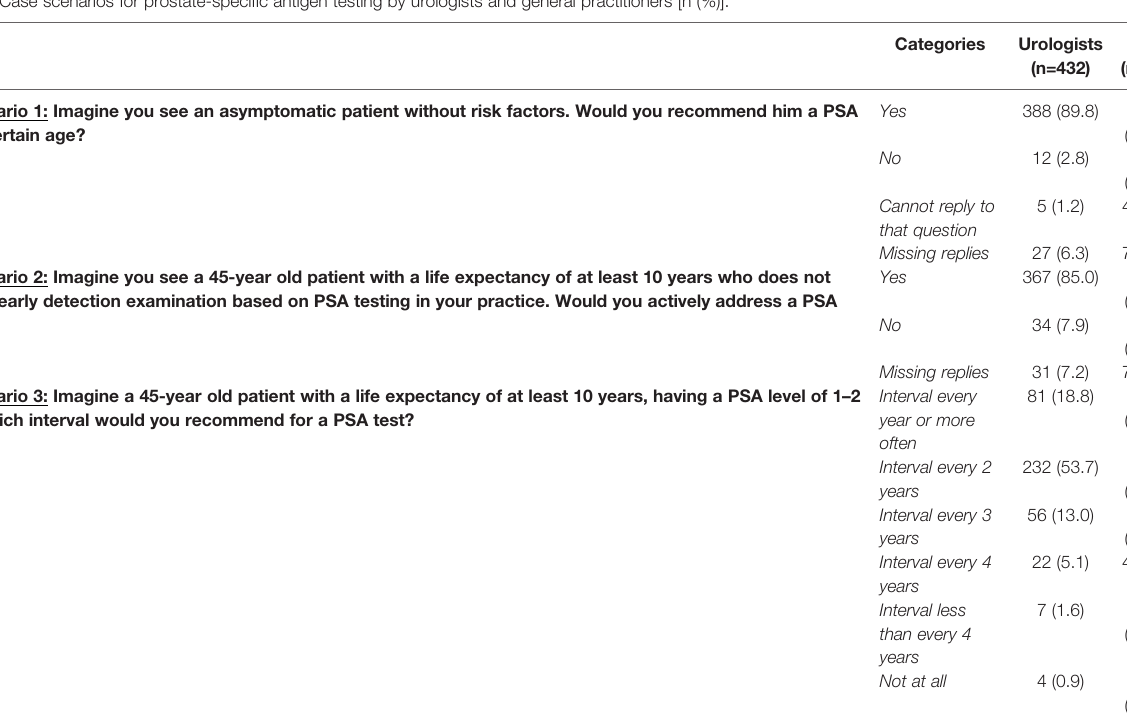
TABLE 5 | Case scenarios for prostate-speci fi c antigen testing by urologists and general practitioners [n